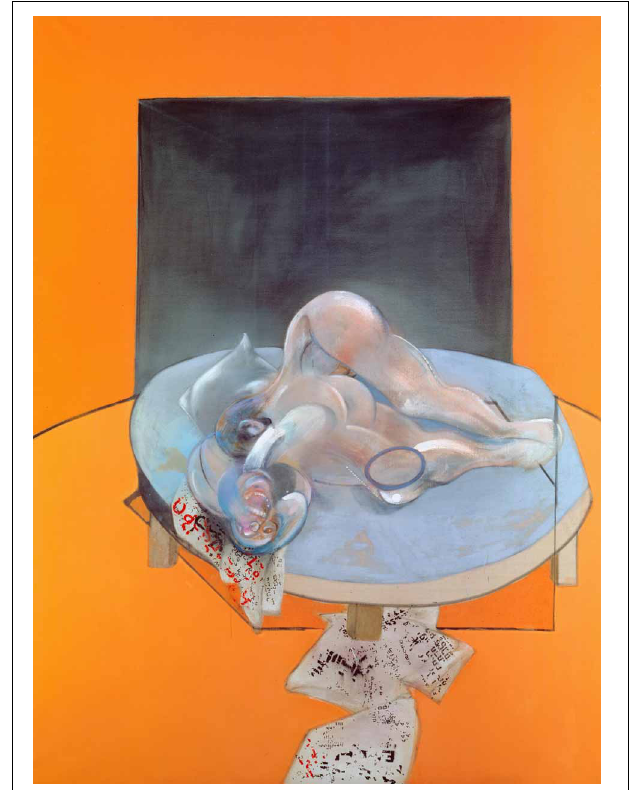
FIGURE 4 | Francis Bacon— Triptych—Studies of the Human Body 1979 (detail of center panel). © The Estate of Francis Bacon. All rights reserved. DACS